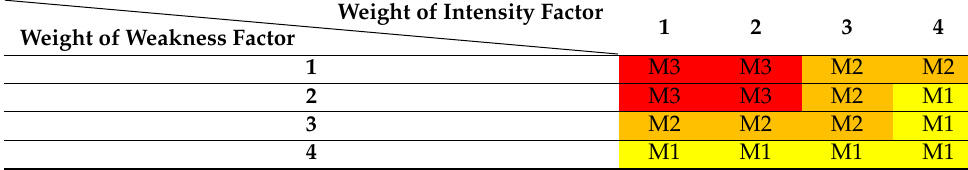
Table 2. Matrix for the evaluation of landslide magnitude (M) by crossing weights of both the Intensity (I) and Weakness (W) factors. Red, orange and yellow colors indicate high (M3), moderate (M2) and low (M1) magnitude